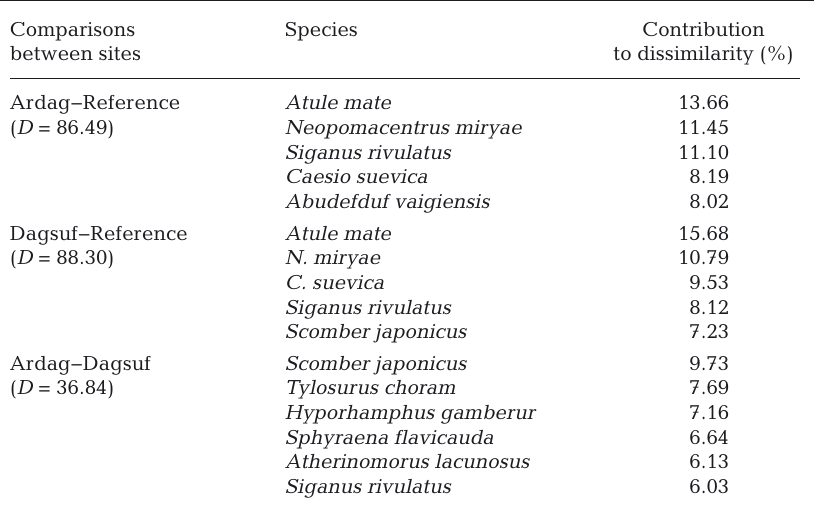
Table 7. Similarity percentage (SIMPER) procedure to test the degree of dissimilarity ( D) between farms and reference sites and between the 2 farm sites on the basis of the abundances of the dominant